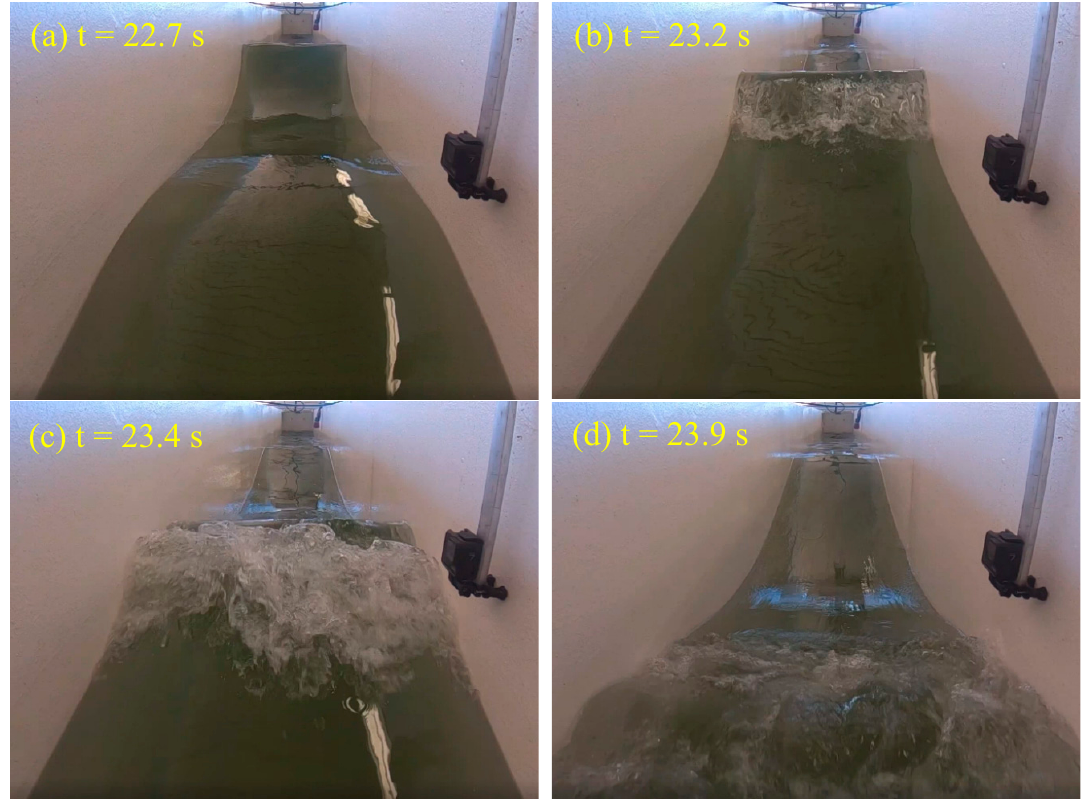
Figure 3. Front views of the breaking wave at various times taken by the GoPro camera: ( a ) the steep wave crest; ( b ) the plunging breaker; ( c ) the secondary breaker, and ( d ) recovery of the free surface.